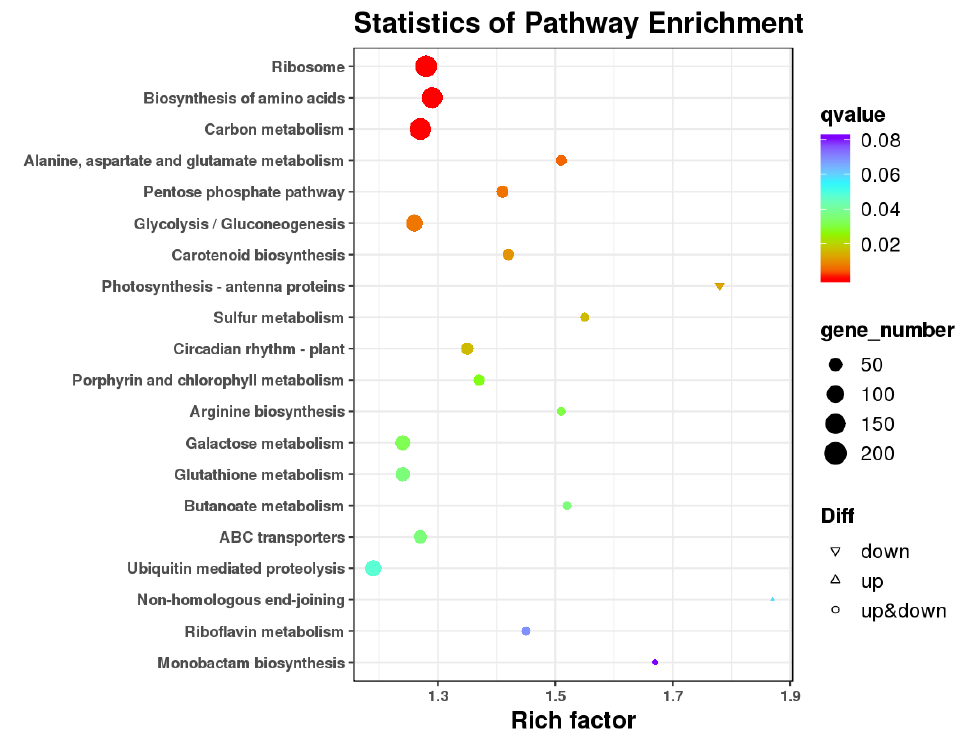
Figure 6. KEGG enrichment of differentially expressed genes (DEGs) in the bark (P) and leaves (Y) of H. chrysantha . The enrichment factor is the ratio of the proportion of genes annotated in a pathway to the proportion of all annotated genes. The color of the circle represents the q-value, and the smaller the q-value, the more reliable the enrichment value of the DEGs in the pathway. The size of the circle indicates the number of genes enriched in the pathway, and the larger the circle is, the more genes were enriched.